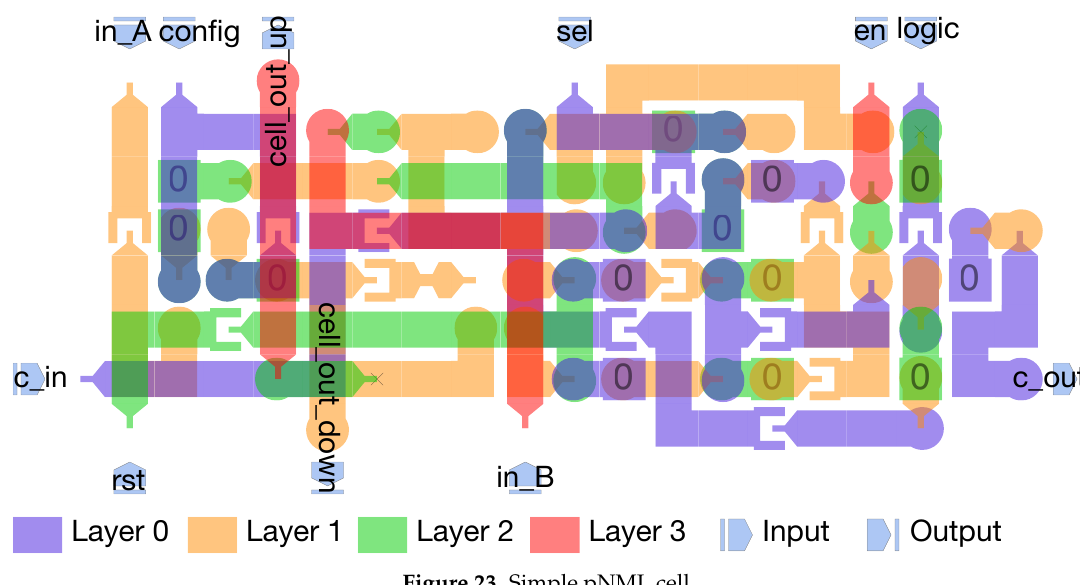
Figure 23. Simple pNML